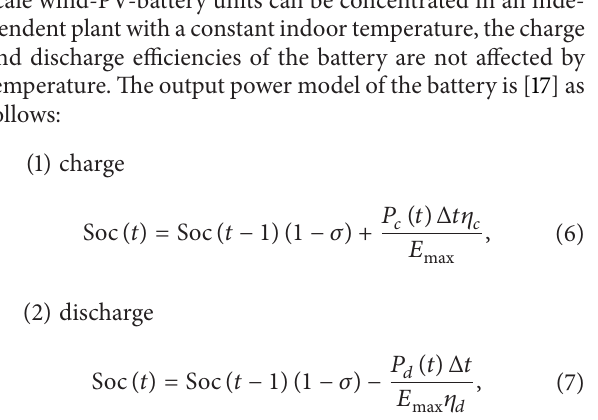
and temperature), thus ensuring the stable grid-connected operation of the wind-PV-battery